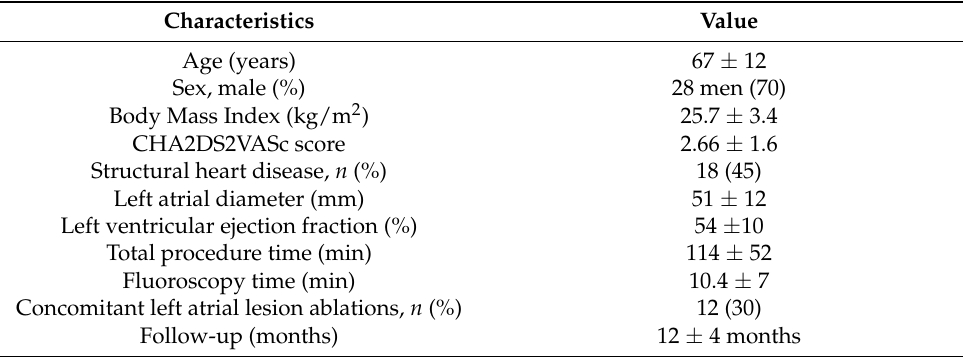
Table 1. Baseline characteristics of study patients ( n =